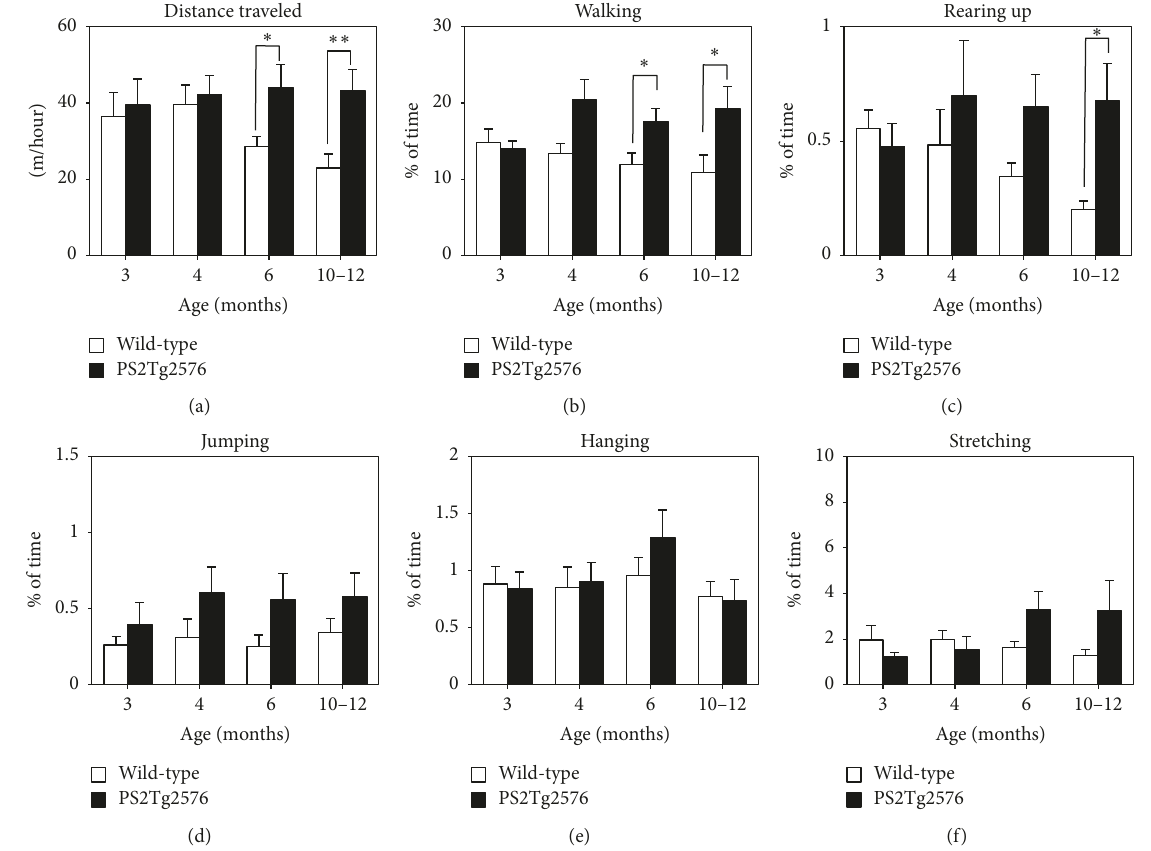
Figure 1: Spontaneous physical activities in PS2Tg2576 mice. The following 6 separate parameters of spontaneous behavior were evaluated in control wild-type mice (open column, 𝑛 = 10 ) and PS2Tg2576 mice (closed column, 𝑛 = 10 ) in the home-cage environment: (a) distance traveled,(b)walking,(c)rearing,(d)jumping,(e)hanging,and(f)bodystretching.Tenmiceofeachgenotypewereused.Theparameterswere analyzed at ages of 3, 4, 6, and 10–12 months. At 6 months, PS2Tg2576 mice exhibited significantly higher spontaneous physical activities for distance traveled (a) and walking (b) ( 𝑝 = 0.03 and 0.025, resp.). At 10–12 months, PS2Tg2576 mice exhibited significantly higher spontaneous physical activities for distance traveled (a), walking (b), and rearing (c) ( 𝑝 = 0.0073 , 0.036, and 0.011, resp.). Data points represent the mean ± SEM. ∗ 𝑝 < 0.05 and ∗∗ 𝑝 < 0.01 versus the corresponding control